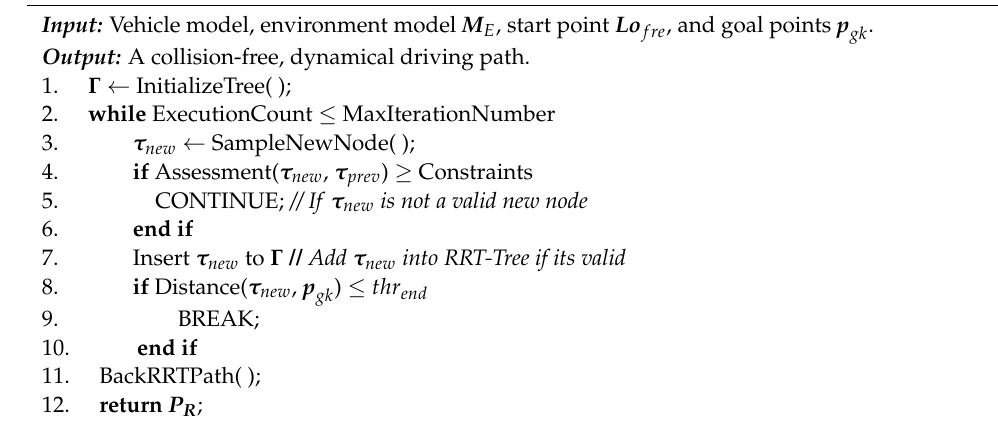
Algorithm 1. RRT searching